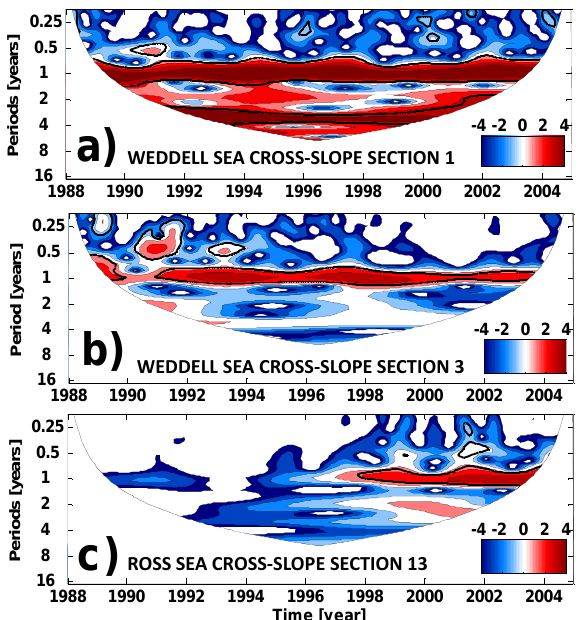
Fig. 10. Wavelet power spectrum of (a) Weddell Sea cross-slope section 1, (b) Weddell Sea cross-slope section 3, (c) and Ross Sea cross-slope section 13 volume transport anomaly using the Morlet wavelet. The white area is the cone of influence, where zero padding has reduced the variance. The black thick contour encloses regions where confidence levels were greater than 90% for a red-noise pro- cess with a lag-1 coefficient of 0.72. The units (colourbar) are the energy in log 2 form.